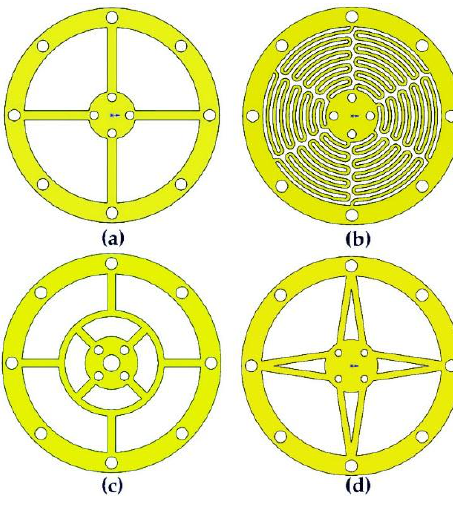
Figure 3. Leaf spring shapes. ( a ) cross; ( b ) serpentine; ( c ) double circular; ( d ) V shape.